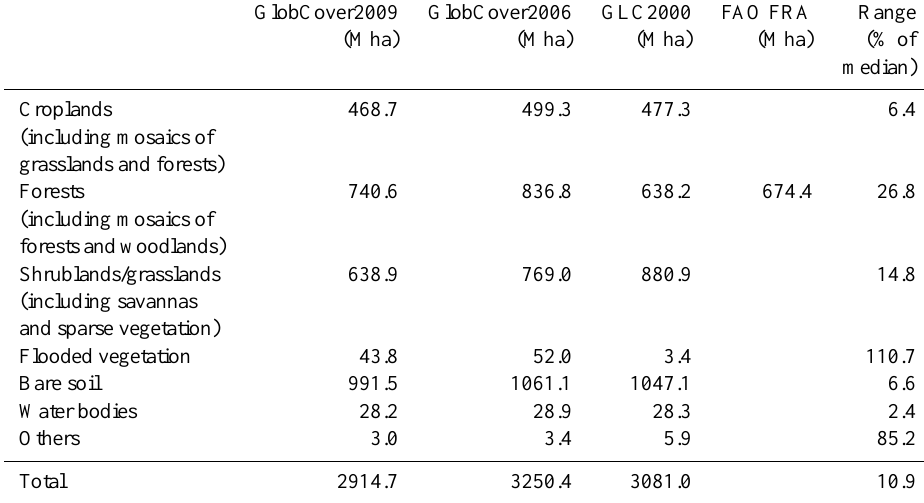
Table 2. Different estimates of land cover in Africa across various products derived by space observation (GlobCover) and inventories